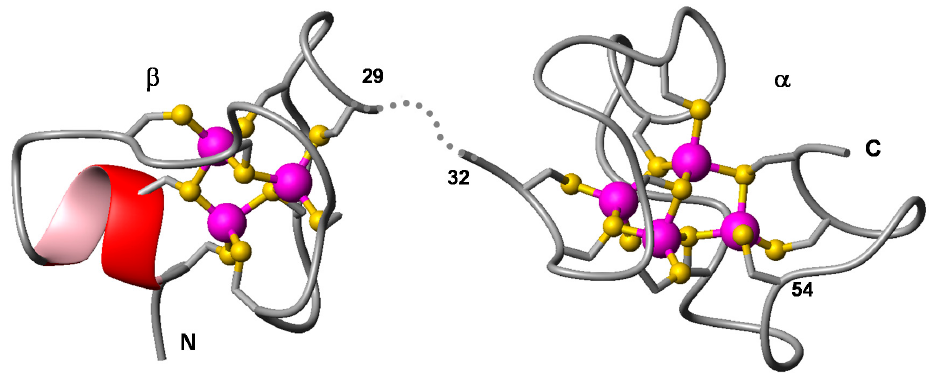
Figure 5. 3D model for C. gariepinus MT showing the canonical M(II) 3 Cys 9 ( β domain) and M(II) 4 Cys 11 ( α domain) clusters. N- and C-terminus are indicated. The initial models were generated in PHYRE 2 [102] and are based on pdb entries 1m0g and 1m0j ( α and β domains of Notothenia coriiceps MTA, respectively [88]). The positions of the Cd(II) ions (magenta spheres) are also taken from these pdb entries. The two domains have been arranged in space by structural alignment with pdb entry 4mt2 (revised X-ray structure of rat liver MT [103]); the dotted line indicates the location for the linker residues 30 and 31, which are not resolved in the template NMR structures and hence also not in the model. The yellow spheres refer to thiolate sulphurs. The location of Cys54, which differs in all fish MTs from that of other vertebrate MTs, is also highlighted.